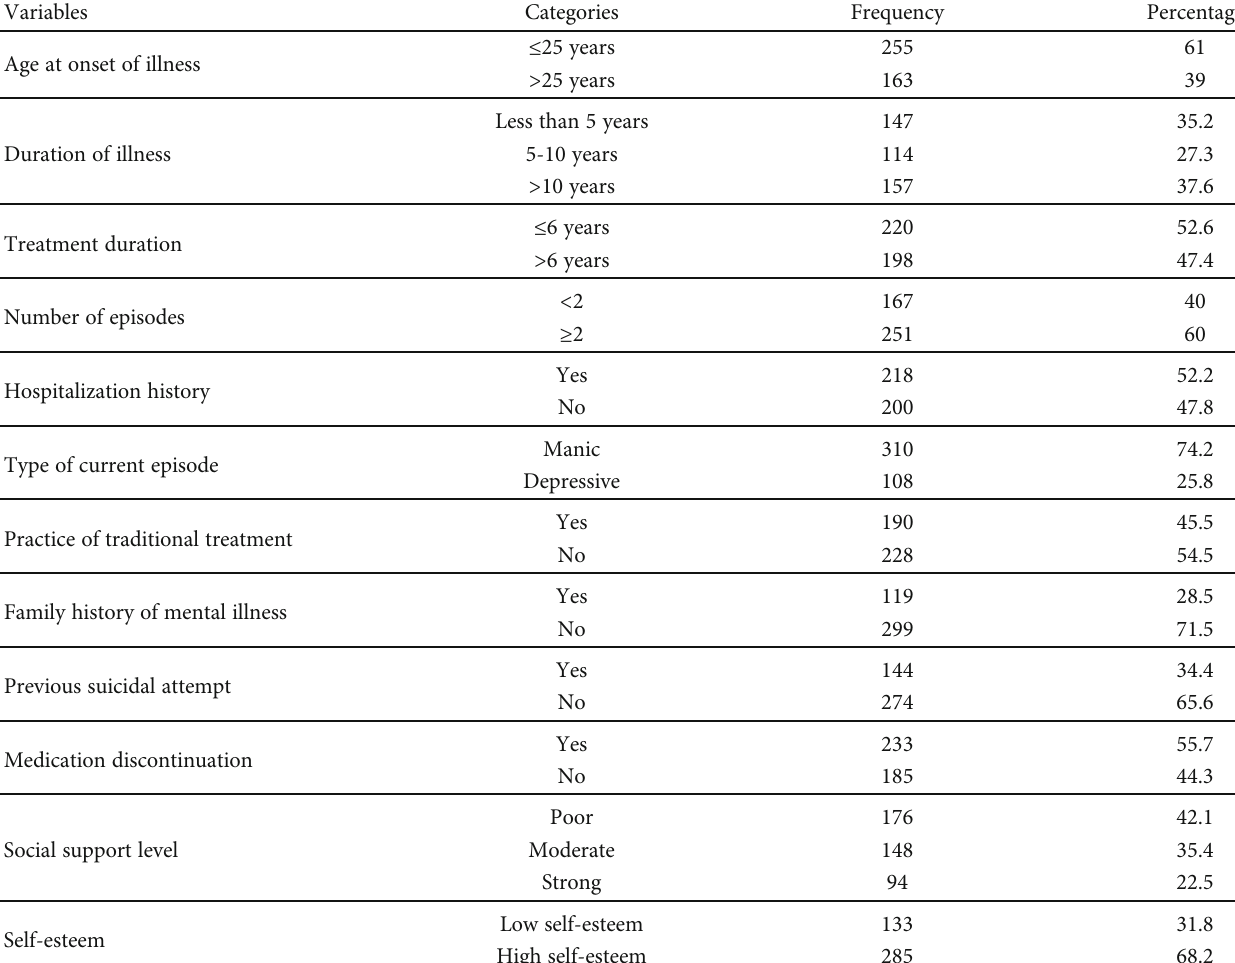
Table 2: Clinical and psychosocial factors of people with bipolar disorder attending the outpatient department at Amanuel Mental Specialized Hospital, Addis Ababa, Ethiopia, 2016 ( n = 418